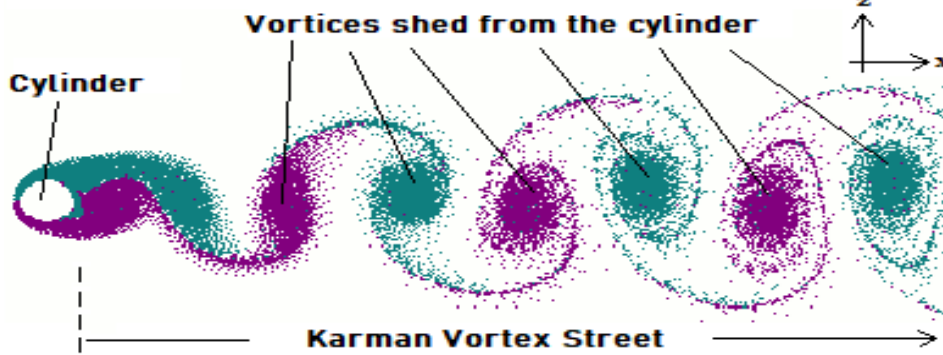
Figure 1. A simple illustration of Karman Vortex Street. When the cylinder is allowed to move in the direction perpendicular to the flow (z axis), the forces exerted on the cylinder by the vortices will actually make the cylinder move up and down. This is a periodic motion and will last forever as the fluid continues to flow. Vortex induced vibrations make use of the flow energy and convert this power of the fluid to oscillate the cylinder. In this study, we are trying to increase vertical mixing in the pond without applying any additional energy input into the system.